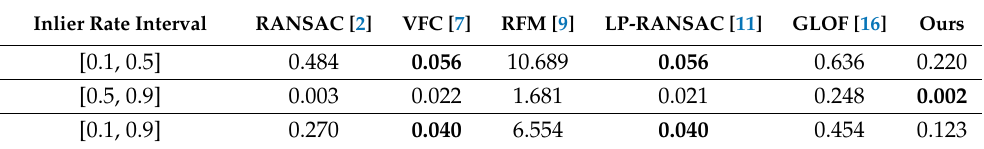
Table 5. Average execution time (in seconds) comparison for the “Small Village” dataset. Inlier Rate Interval